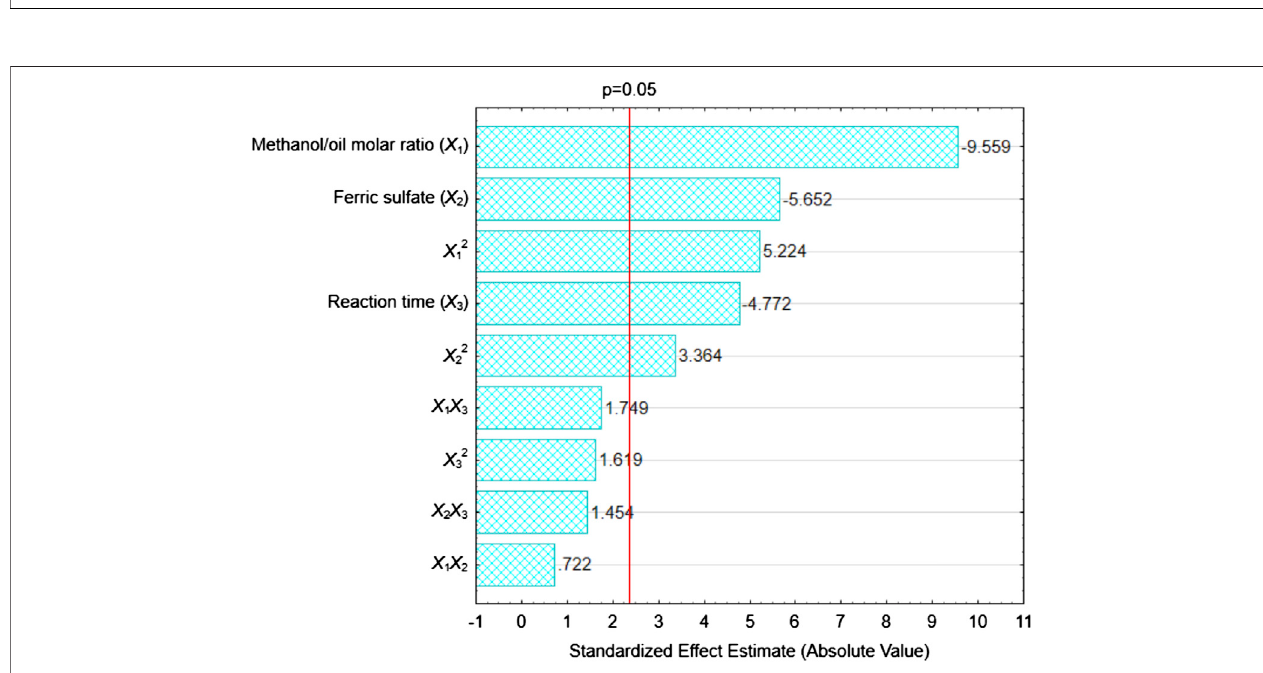
FIGURE 4 | Pareto chart indicating signi fi cant level for all model